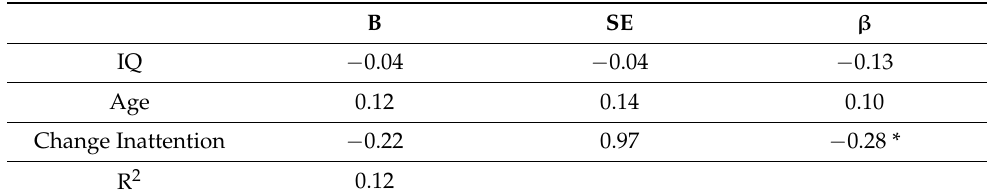
Table 2. Multivariate regression where changes in inattention measured by ADHD-RS predicted the change in children’s affective empathy measured by